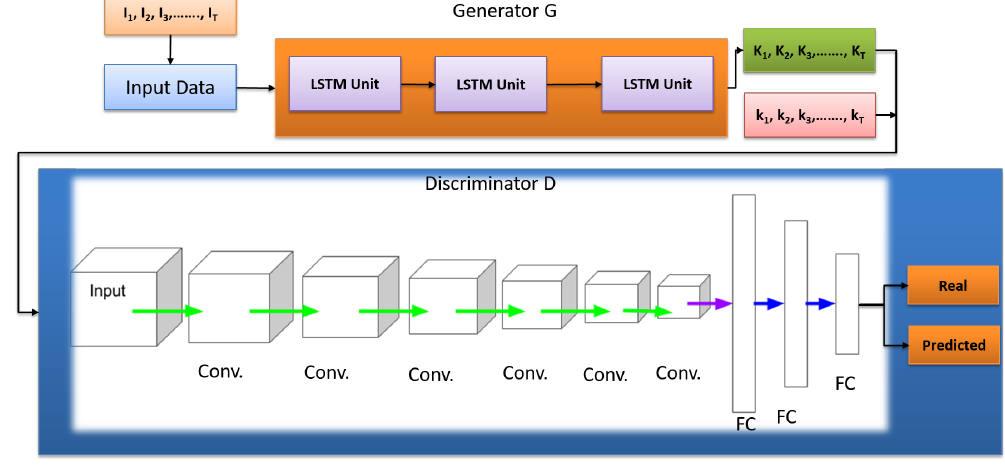
Figure 7. Design of GAN deep learning